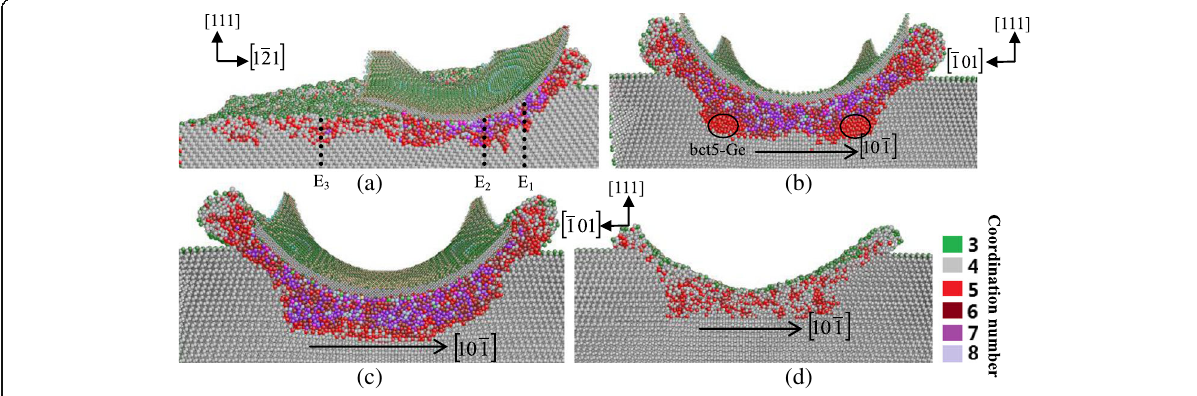
(cid:1) (cid:3) direction on the (111) plane. a On the 101 (cid:4)